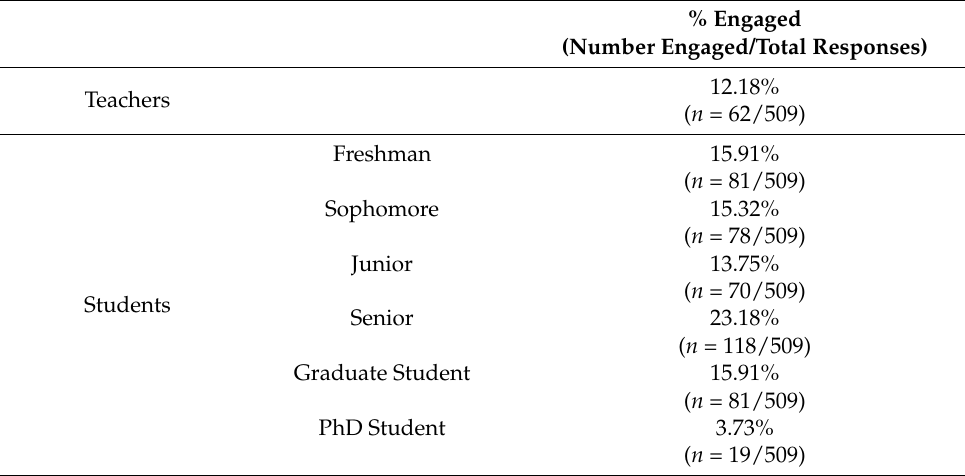
Table 3. Number of teachers and students participating in the